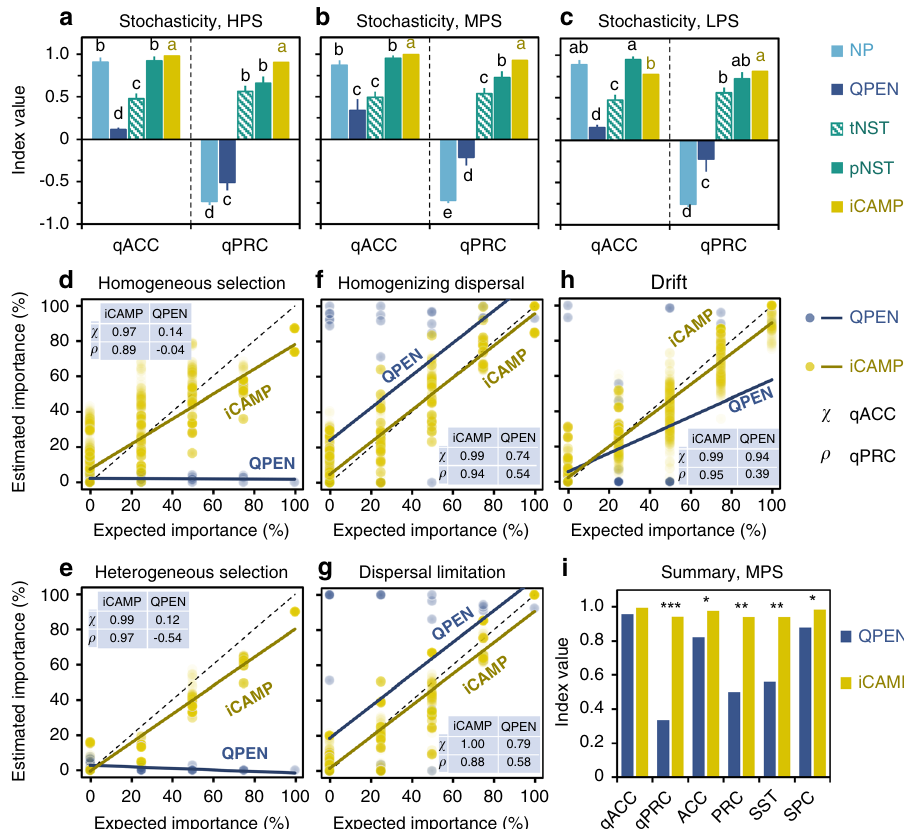
Fig. 2 Performances of iCAMP and other approaches with simulated communities. a – c The performances of different approaches in quantifying ecological stochasticity under high-phylogenetic-signal (HPS), medium-phylogenetic-signal (MPS), and low-phylogenetic-signal (LPS) scenarios, which were assessed by quantitative accuracy (qACC) and precision (qPRC). Data are presented as mean values ± SD. Error bars indicate standard deviations based on n = 1000 times bootstrapping from 15 independent situations. d – h The performances of iCAMP ( n = 4140 comparisons = 276 comparisons among 24 biologically independent samples in each of 15 situations) and QPEN ( n = 60 groups = 4 groups of comparisons among 24 biologically independent samples in each of 15 situations) were also evaluated based on the consistency between the estimated and expected relative importance of different individual ecological processes under MPS scenario. i Overall performance of iCAMP ( n = 4140) and QPEN ( n = 60) under MPS scenario assessed with six performance indexes: qACC ( χ ), qPRC ( ρ ), qualitative accuracy (ACC), qualitative precision (PRC), sensitivity (SST), and speci fi city (SPC). QPEN quantifying assembly processes based on entire-community null model analysis; NP abundance-weighted neutral taxa percentage; tNST and pNST taxonomic and phylogenetic normalized stochasticity ratio. One-side signi fi cance based on bootstrapping test ( n = 1000) was indicated by a – c different letters ( p < 0.05, see Source Data fi le for exact p values), or i *** p < 0.001; ** p < 0.01; * p < 0.05 ( p = 0.130, 0.000, 0.023, 0.007, 0.008, 0.031 for qACC, qPRC, ACC, PRC, SST, SPC, respectively). Source data are provided as a Source Data fi Fig. 13a, b) although not signi fi cant ( p = 0.174). QPEN suggested